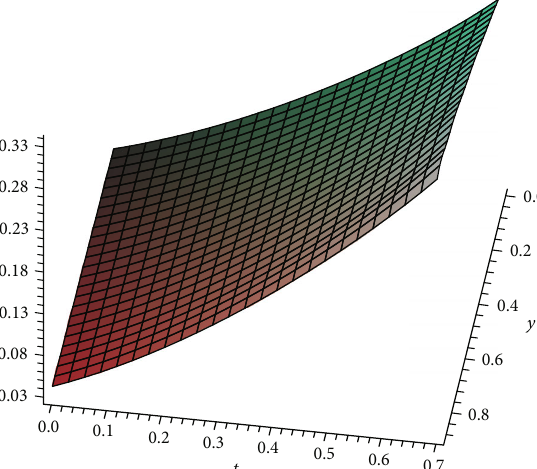
, where g ð x Þ = L